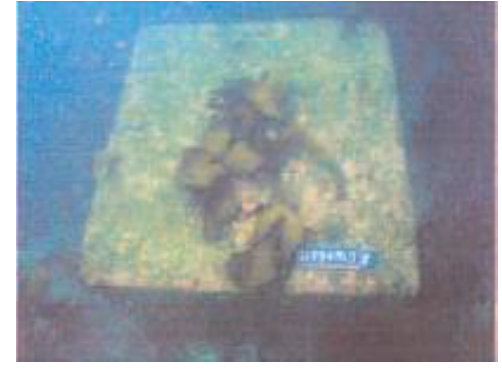
Figure 21. Comparison of seaweed adhesion to normal concrete and marine concrete: more seaweeds were adherent to marine block than concrete block (JFE Steel